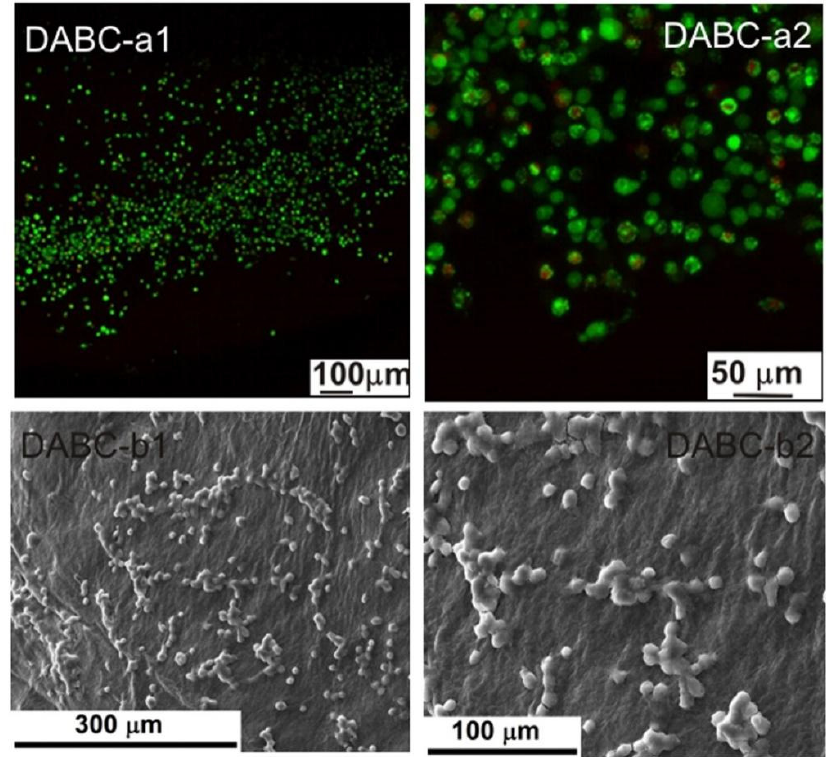
Figure 11 . Fluorescence microscopy images ( a1 , a2 ) and SEM images ( b1 , b2 ) of the adherent cells in a BC ‐ CP2 sample.